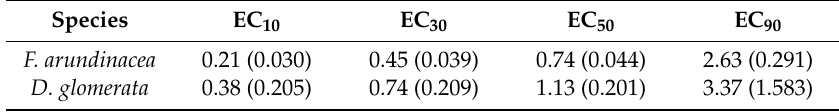
Table 1. EC 10 , EC 30 , EC 50 , and EC 90 (e ff ective concentration) values (mg L − 1 ) estimated from dose responsecurvesofaerialbiomassofregrowthof F.arundinacea (tallfescue)and D.glomerata (orchardgrass) treated with di ff erent S-metolachlor (SMR) concentrations (Figure 2). Regrowth was measured at 87 days after treatment (DAT) after the mowing at 36 DAT. Standard errors are in parenthesis.